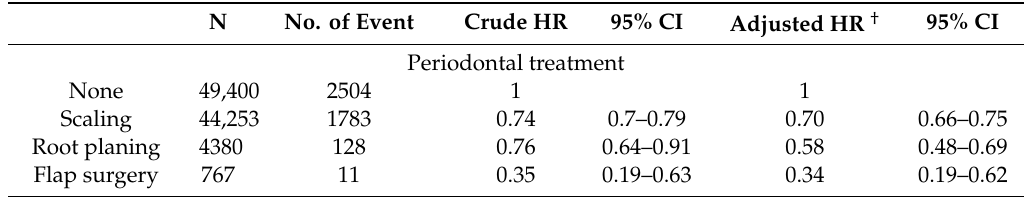
Table 4. Hazard ratios of pneumonia development among di ff erent periodontal